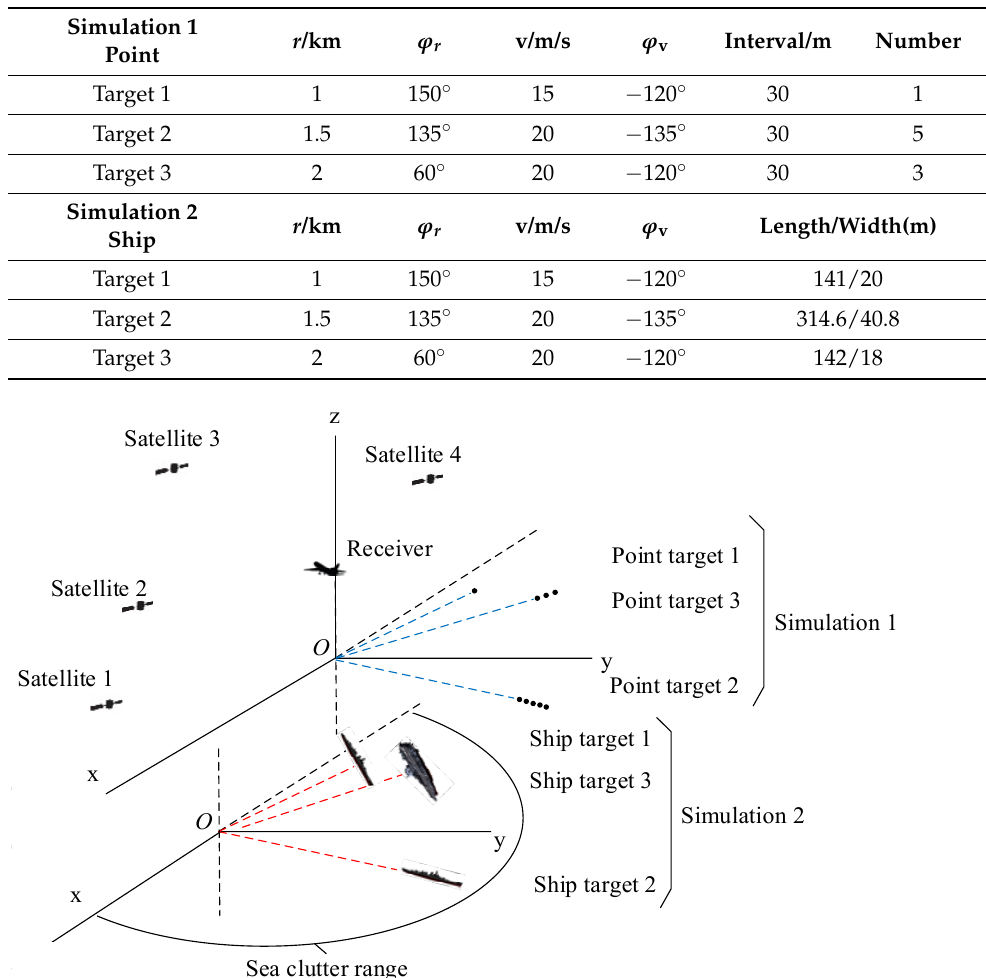
Figure 7. Geometry schematic diagram of multi-signal and multi-target detection simulation.